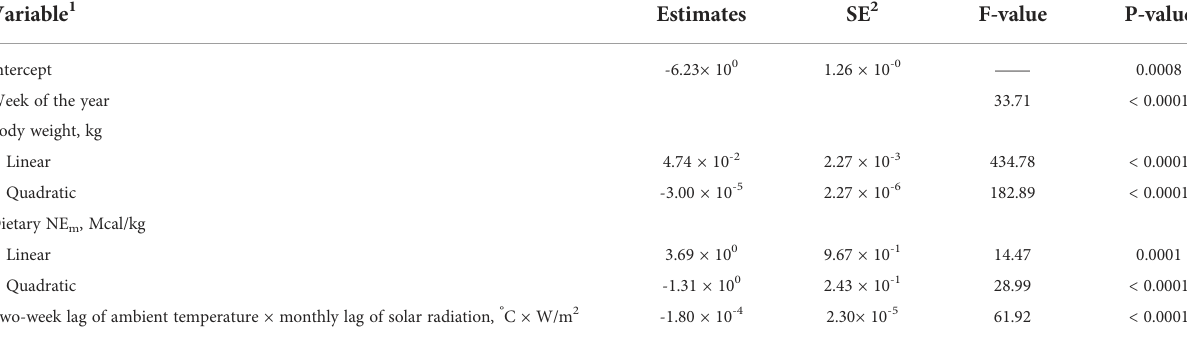
TABLE 9 Base model and interaction between two-week lag of ambient temperature and monthly lag of solar radiation using restricted maximum likelihood estimation method ( fi nal model).